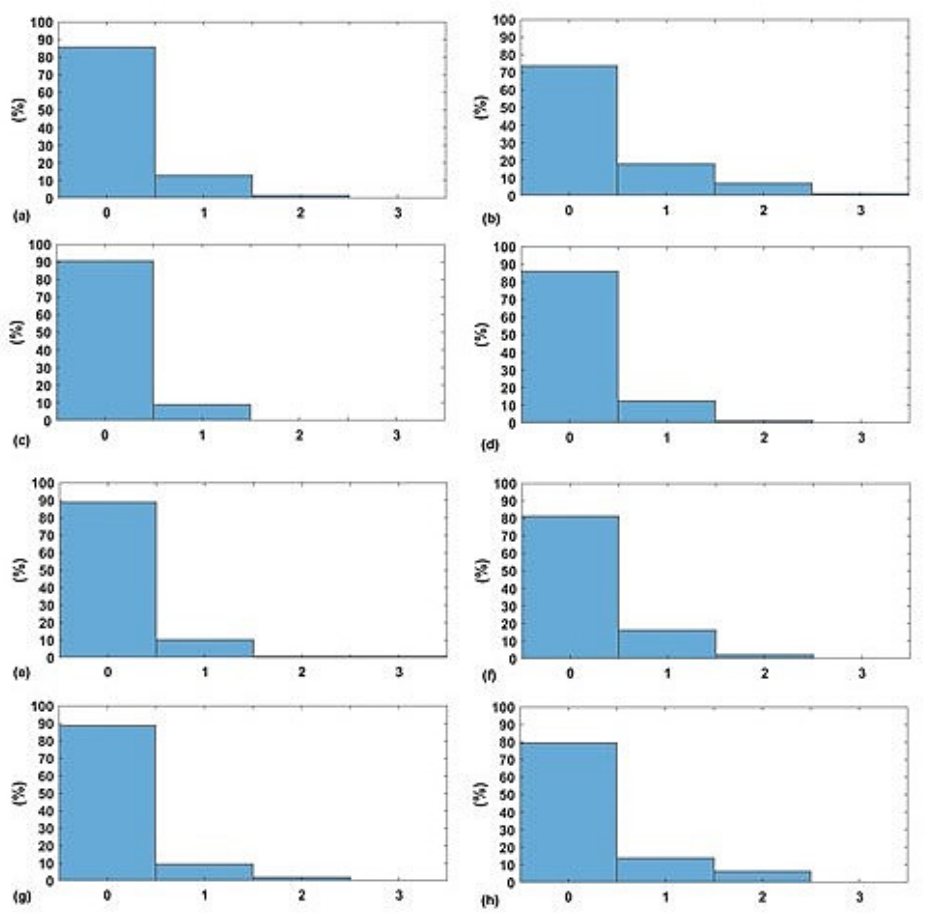
Figure 10. The normalised histogram of EWS components absolute error for both kNN-LS-SVM and Nieve predictors respectively of ( a , b ) HR, ( c , d ) SBP, ( e , f ) Sp O 2 , and ( g , h ) RR for postsurgical